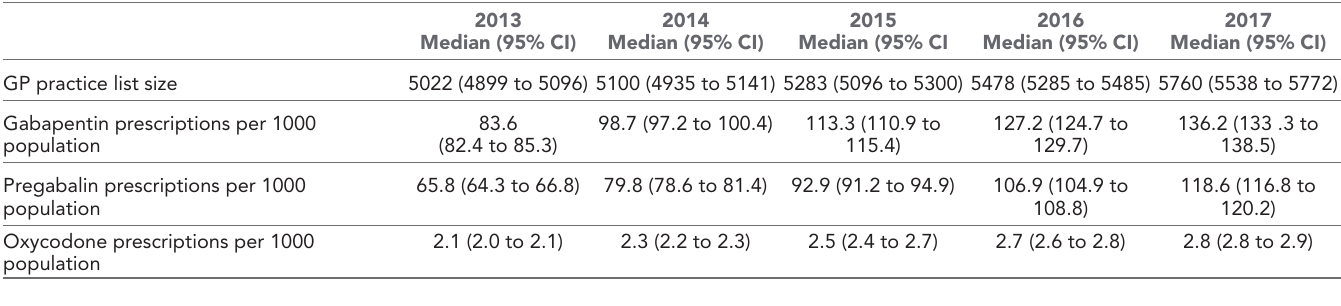
Table 2 Median GP practice list size, median rate of gabapentin, pregabalin, and oxycodone prescriptions per 1000 population per GP